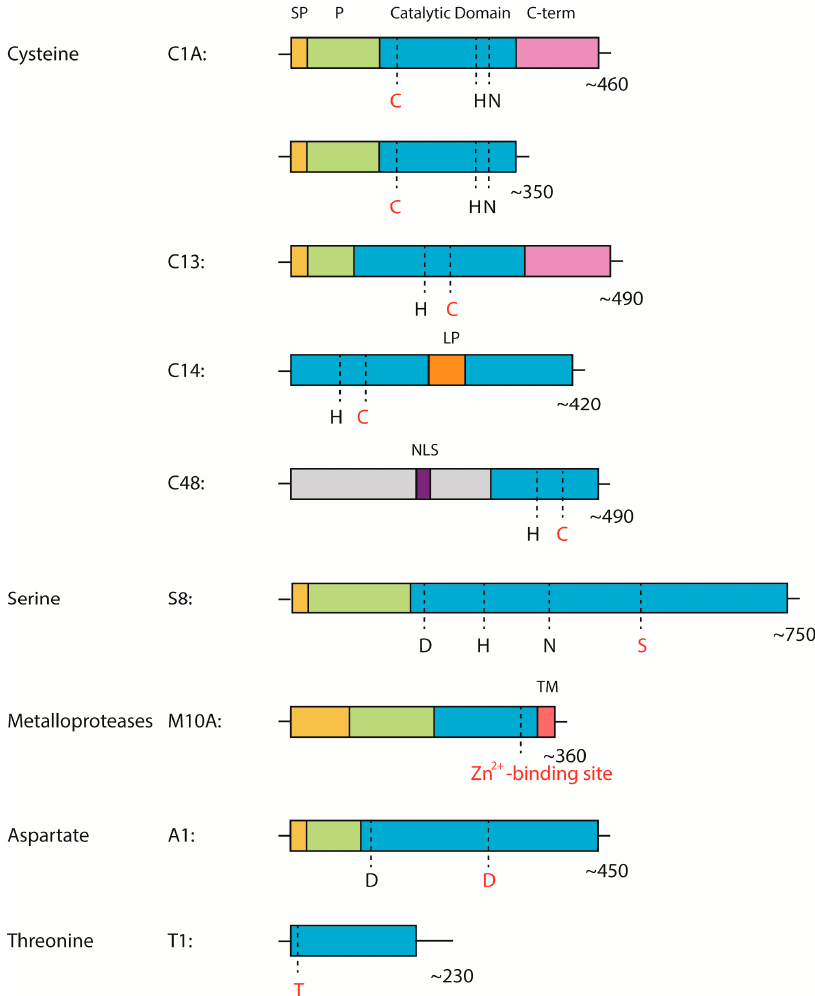
Figure 2. The domain architecture of proteases covered in the review from different protease families. Red letters represent catalytic amino acid residues. SP—signal peptide, P—prodomain, C-term—C-terminal domain or granulin domain (for family C1A proteases), LP—linker peptide, NLS—nuclear localization signal, TM—transmembrane region, regions in grey—low complexity regions.